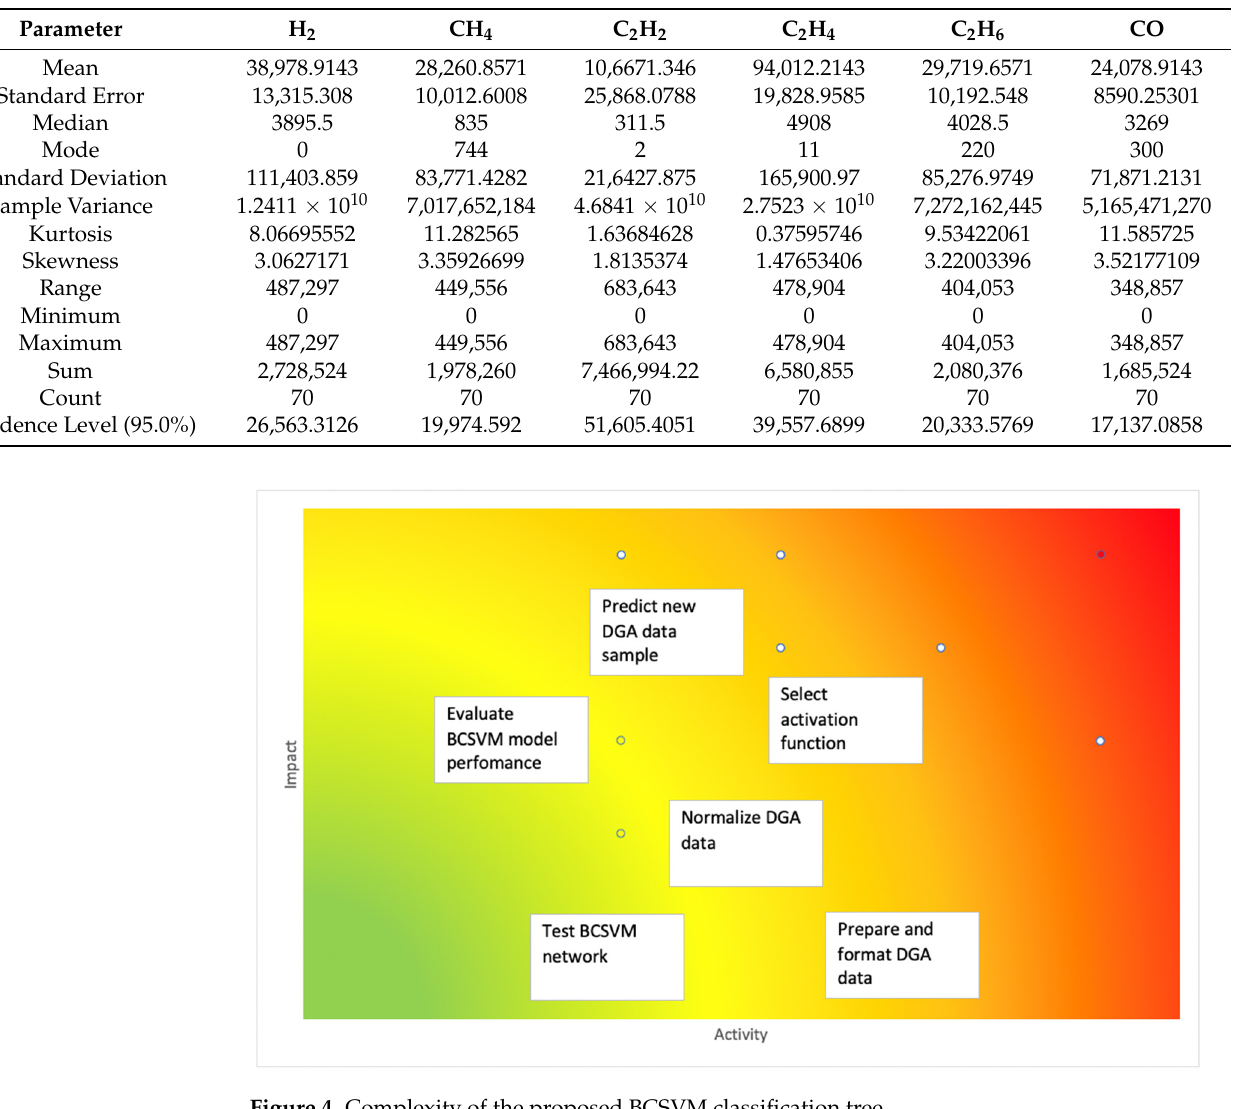
Figure 4. Complexity of the proposed BCSVM classification tree.